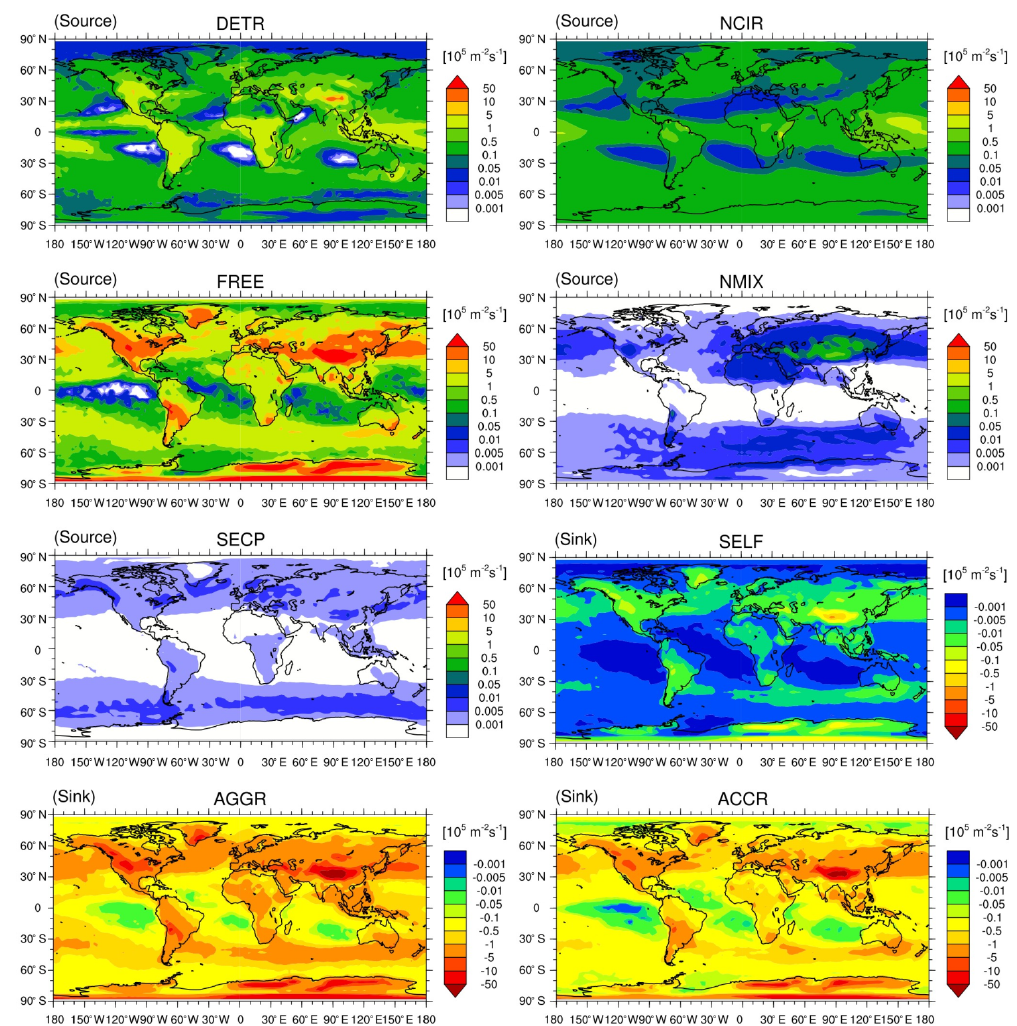
Figure 5. Annual means of the vertically integrated tendencies (in 10 5 m − 2 s − 1 ) for sources and sinks of ICs in cold clouds